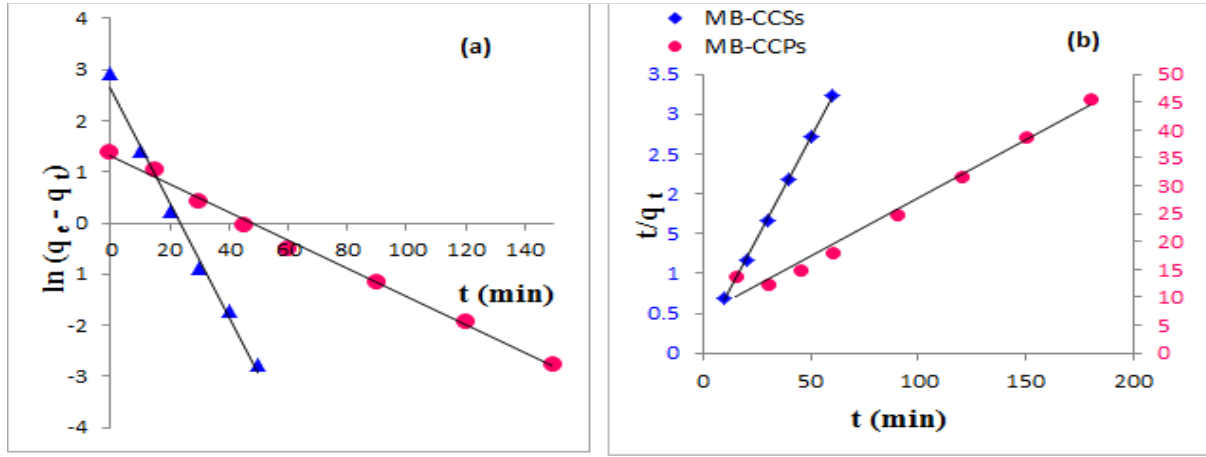
Figure 10. Adsorption kinetic models: ( a ) pseudo-first order, ( b ) pseudo-second order. It was observed that the experimental data of MB adsorbed by CCSs fitted perfectly to the pseudo-second order (R 2 = 0.9994) rather than pseudo-first order (R 2 = 0.991). Moreover, there was only a small difference between q e,exp (18.832 mg g −1 ) and q e,cal (19.531 mg g −1 ), confirming the suitability of the pseudo-second order mechanism process, while the pseudo-first order was the model that best fitted the experimental data of MB sorp- tion by CCPs, which was due to the high value of R 2 (0.9947), compared to pseu- do-second-order (R 2 = 0.9803). Kinetic data results revealed that the MB adsorption by CCSs and CCPs followed chemisorption and physisorption, respectively [63].